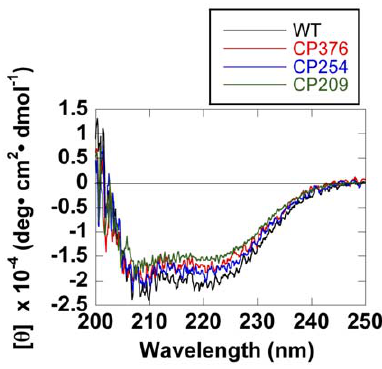
Figure 2. CD spectra of wild type and CP GroELs. Spectra were recorded at 25 u